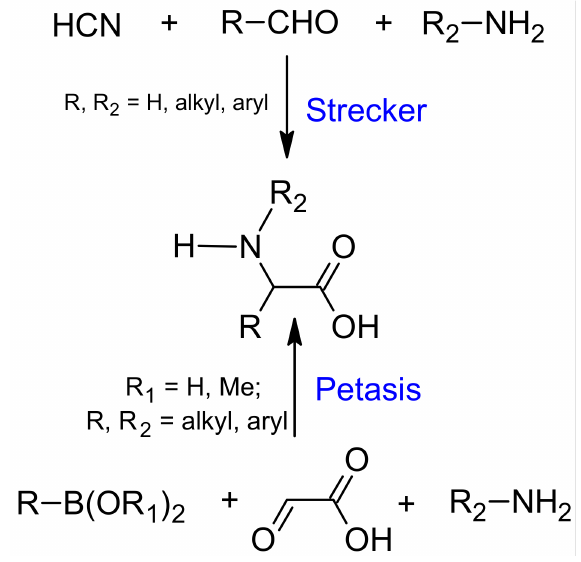
Scheme 1. General Petasis and Strecker amino acid